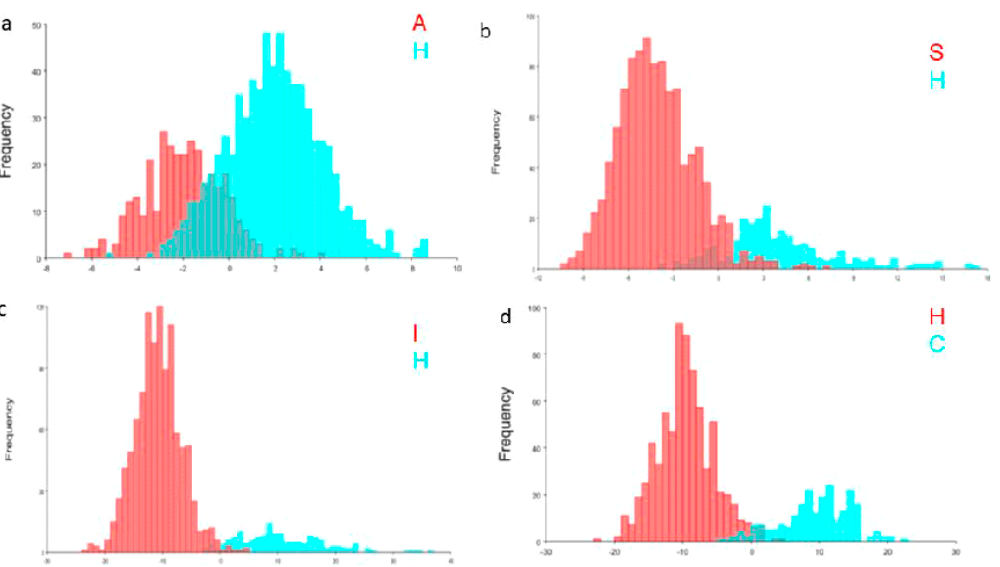
Figure 5. Discrimination analysis (DA) of leaf shape for pairs of species. ( a ) Q. afares (A) vs. Hybrids (H), ( b ) Q. suber (S) vs. Hybrids (H), ( c ) Q.ilex (I) vs. Hybrids (H), ( d ) Q. canariensis (C) vs. Hybrids (H).